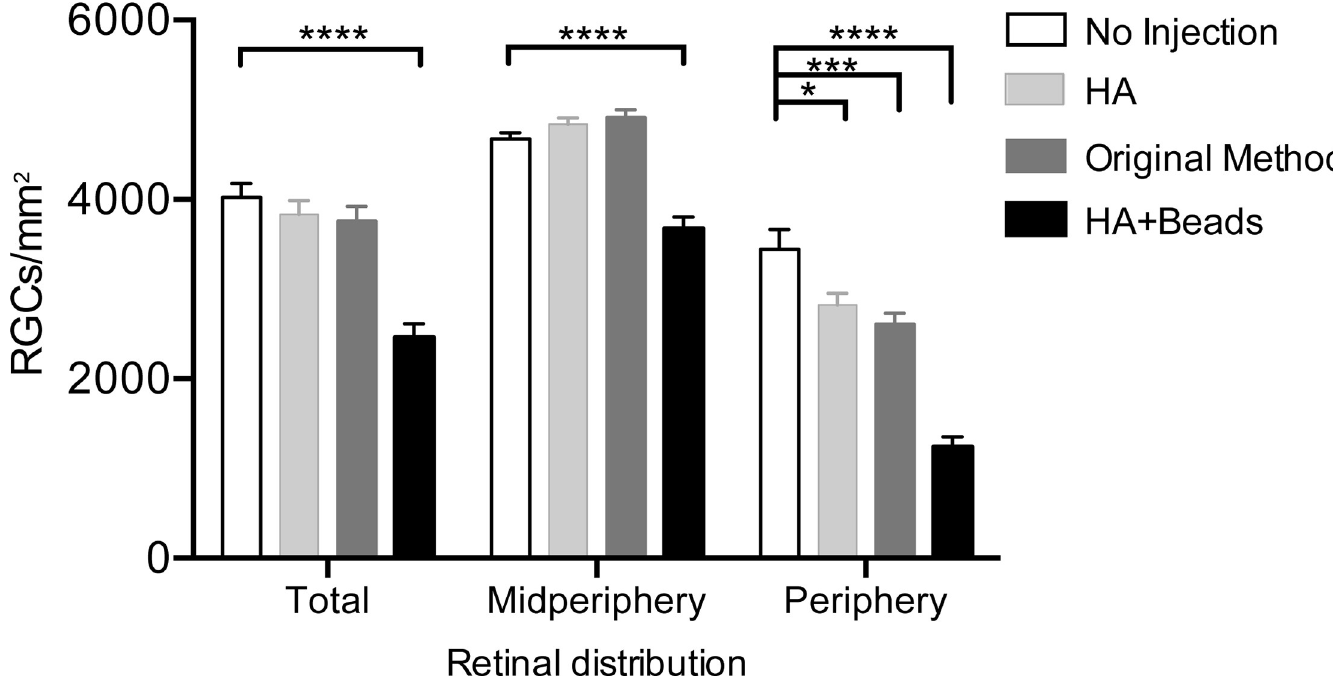
Fig 5. Quantification of RGC damage in different regions of retinal flatmounts immunostained with Brn-3a. Brn-3a staining revealed a significant reduction in peripheral RGC density in each group compared to untreated eyes (white bar). In the hyaluronic acid (HA) + beads group (black bar), significant decreases were also detected in the midperipheral area compared to untreated eyes ( p < 0.001). Total RGC density was calculated as the average RGC number in both the midperiphery and periphery. ���� p < 0.0001, ��� p < 0.001, � p < 0.05.